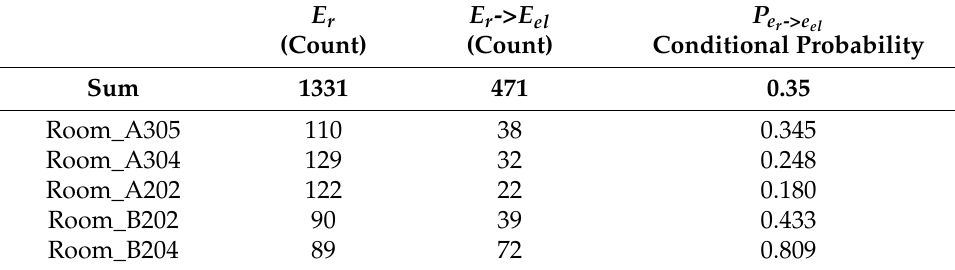
Table 5. Inferred results on event-conjunction of several representative